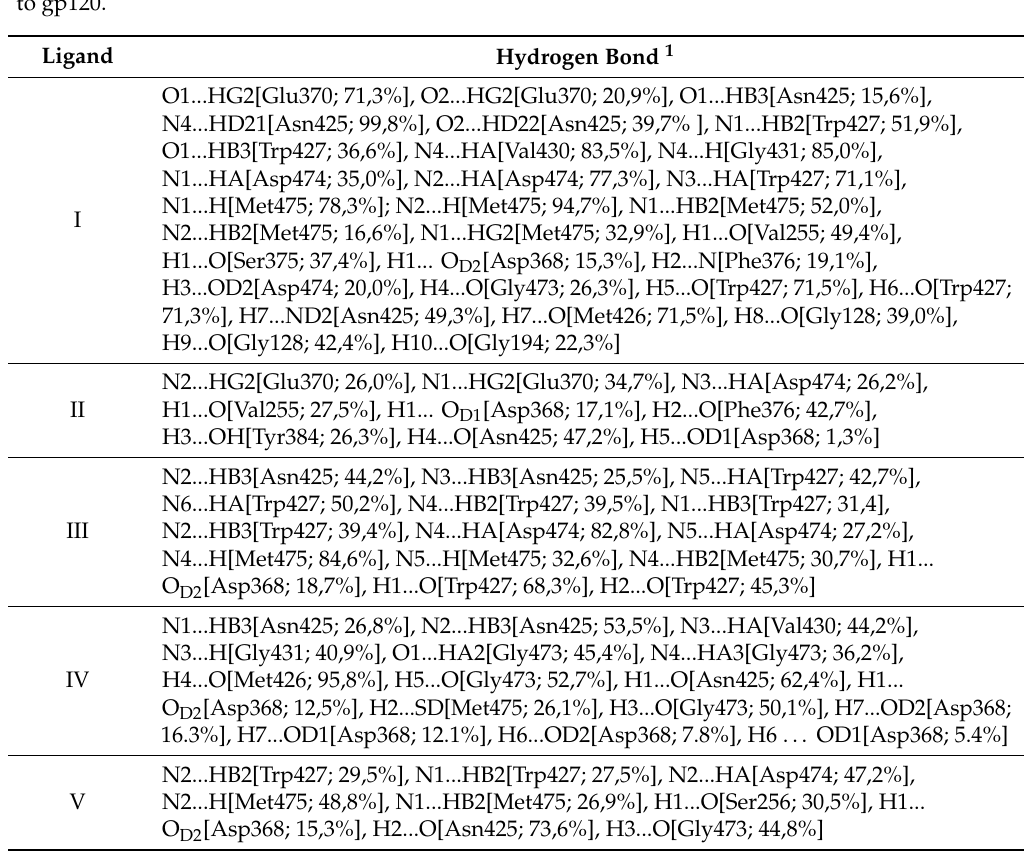
Table 6. Intermolecular hydrogen bonds in the dynamic structures of the identified compounds bound to